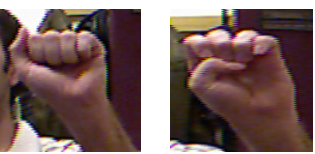
Figure 3. Similarity between sign images: ‘a’ ( left ) and ‘e’ ( right ).